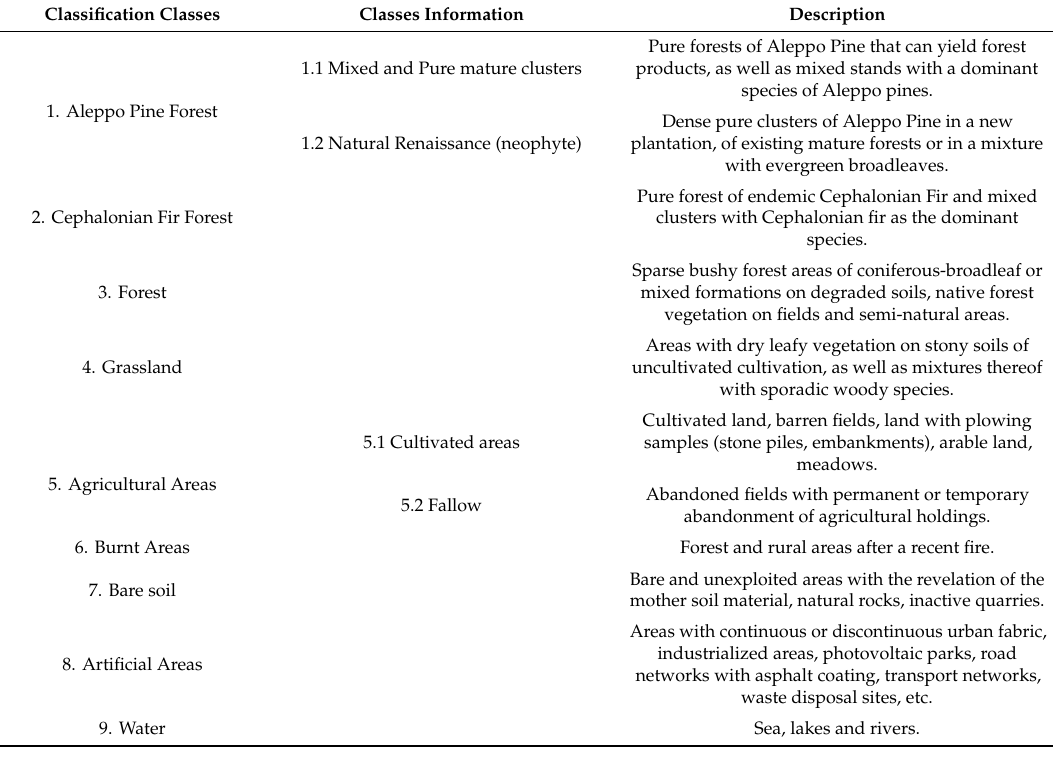
Table 2. Final post-processing Land Use and Land Cover (LULC)